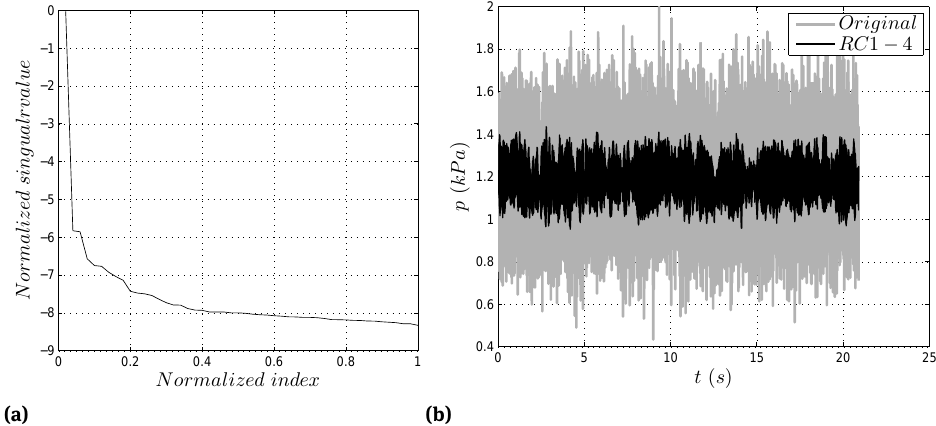
Figure 8: a) Singular value spectra and b) Source signal and sum of its three first principal components at transient phase (TOA = 10%) at the blower inlet